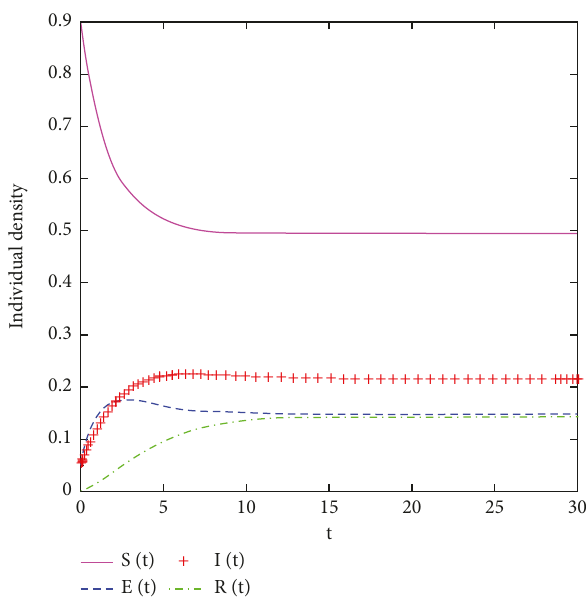
Figure 3: Simulation result of risk contagion in the case of R 0 <